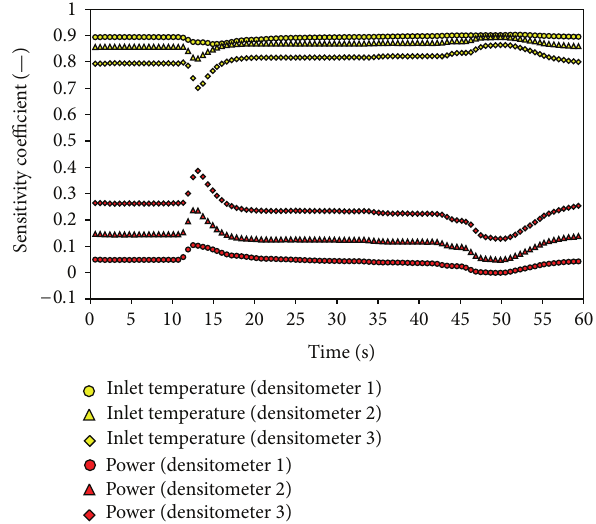
Figure 8: Sensitivity coefficients related to the void fraction during the turbine pump trip at three axial elevations (TRACE-SUSA).